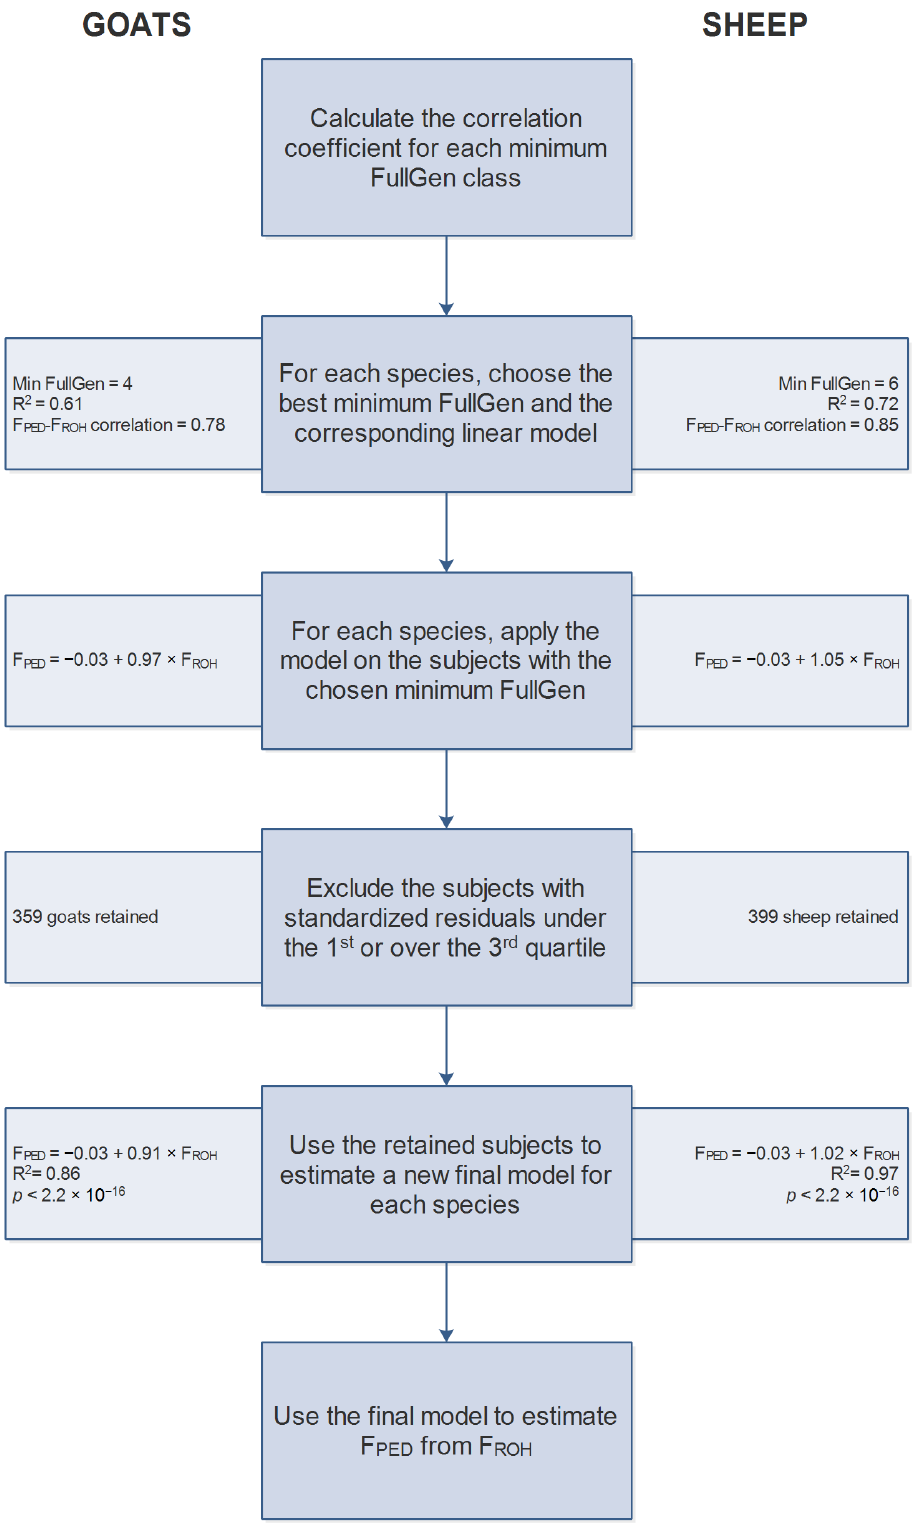
Figure 2. Flowchart of the estimation of a linear regression model estimating F PED from F ROH for goats and sheep.